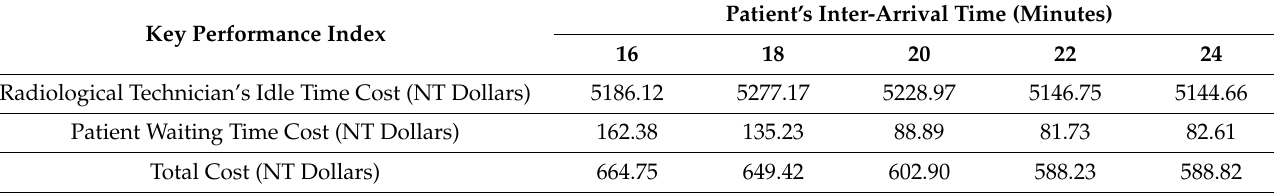
Table 17. Sensitivity analysis 4 with the pair cost coefficients (0.1,